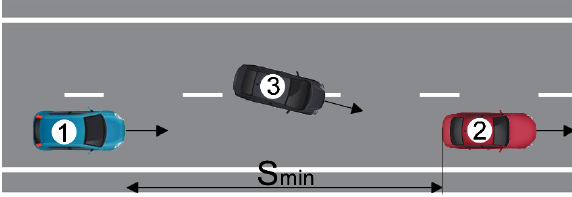
Figure 1: Diagram of the driving behavior of a vehicle which, by changing lanes, enters in front of the vehicle maintaining the neces- sary distance behind the vehicle ahead